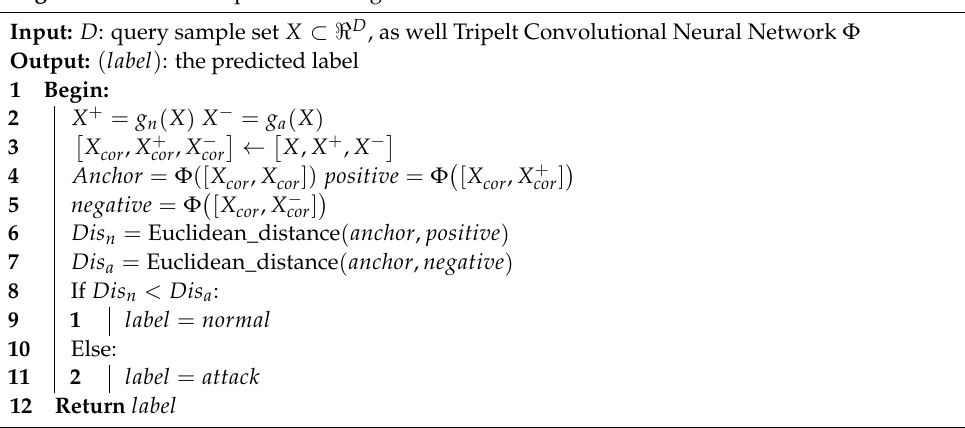
Algorithm 2 MCLDM prediction